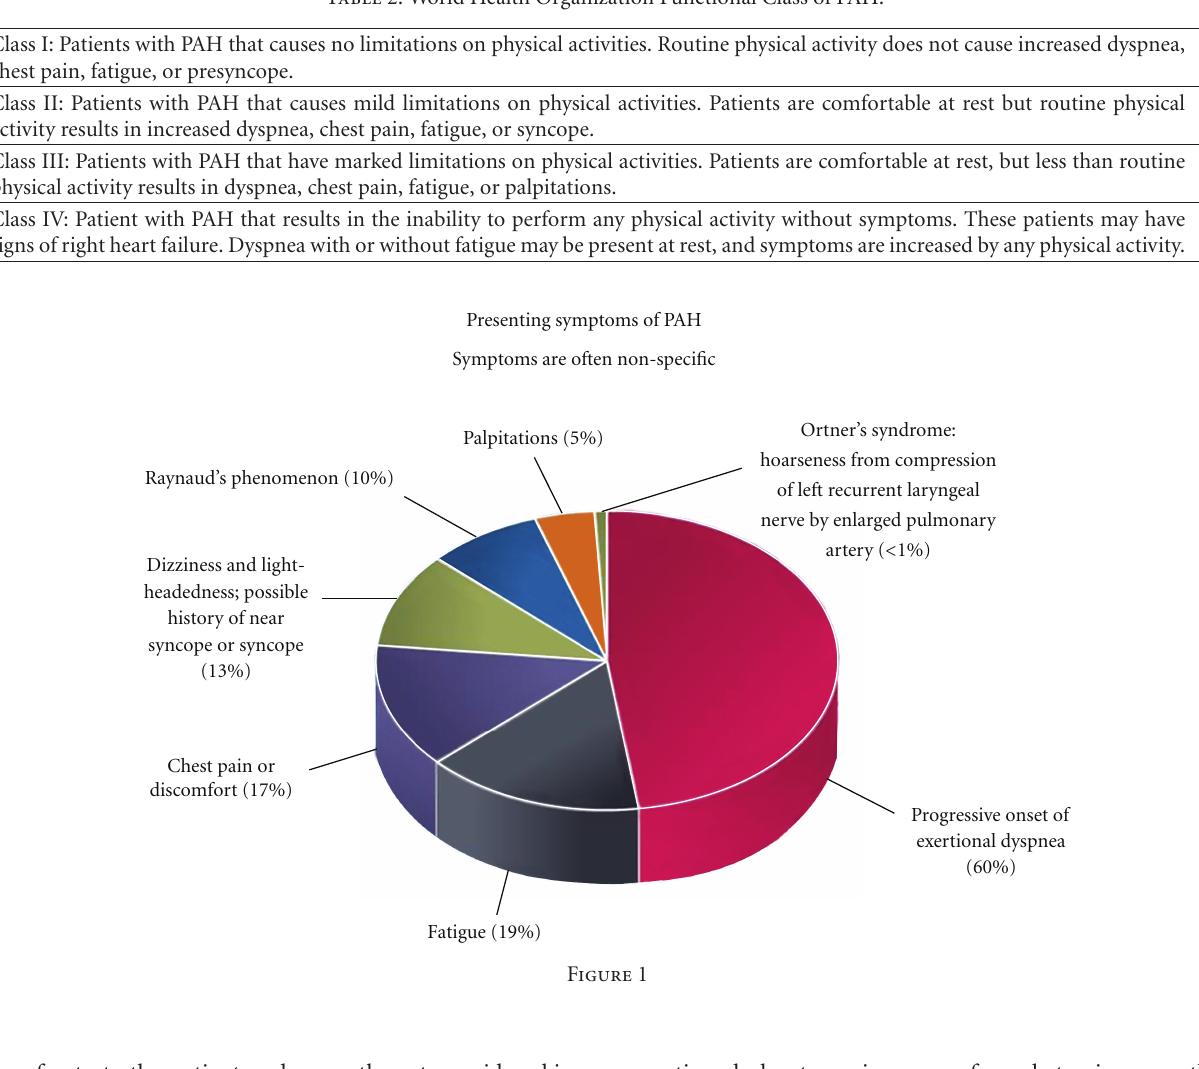
Table 2: World Health Organization Functional Class of